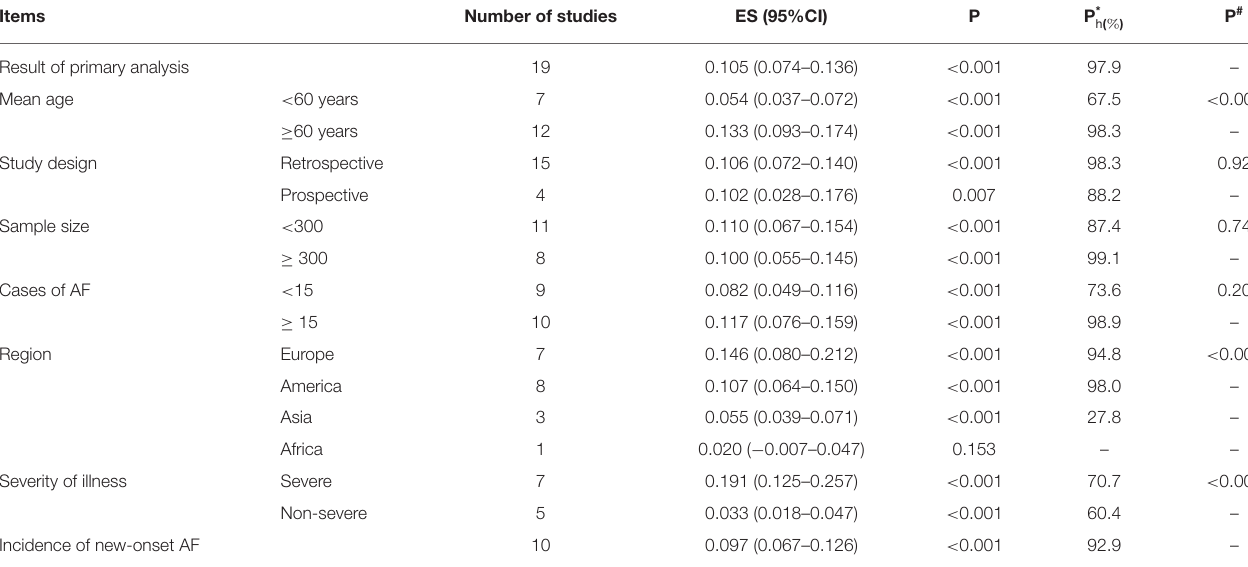
TABLE 2 | Subgroup analysis of prevalence of AF in patient with COVID-19.